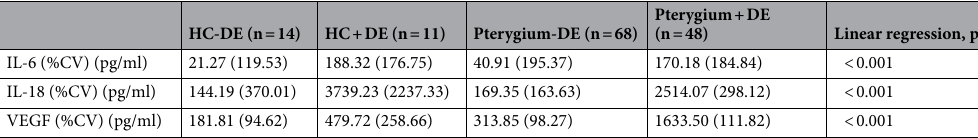
Table 3. Geometric mean of tear cytokine concentration in subgroup analysis considering dry eye status. HC- DE = healthy control without dry eye; HC + DE = healthy control without dry eye; Pterygium-DE = pterygium participants without dry eye; Pterygium + DE = pterygium participants with dry eye; IL = interleukin; VEGF = vascular endothelial growth factor; %CV = percent coefficient of